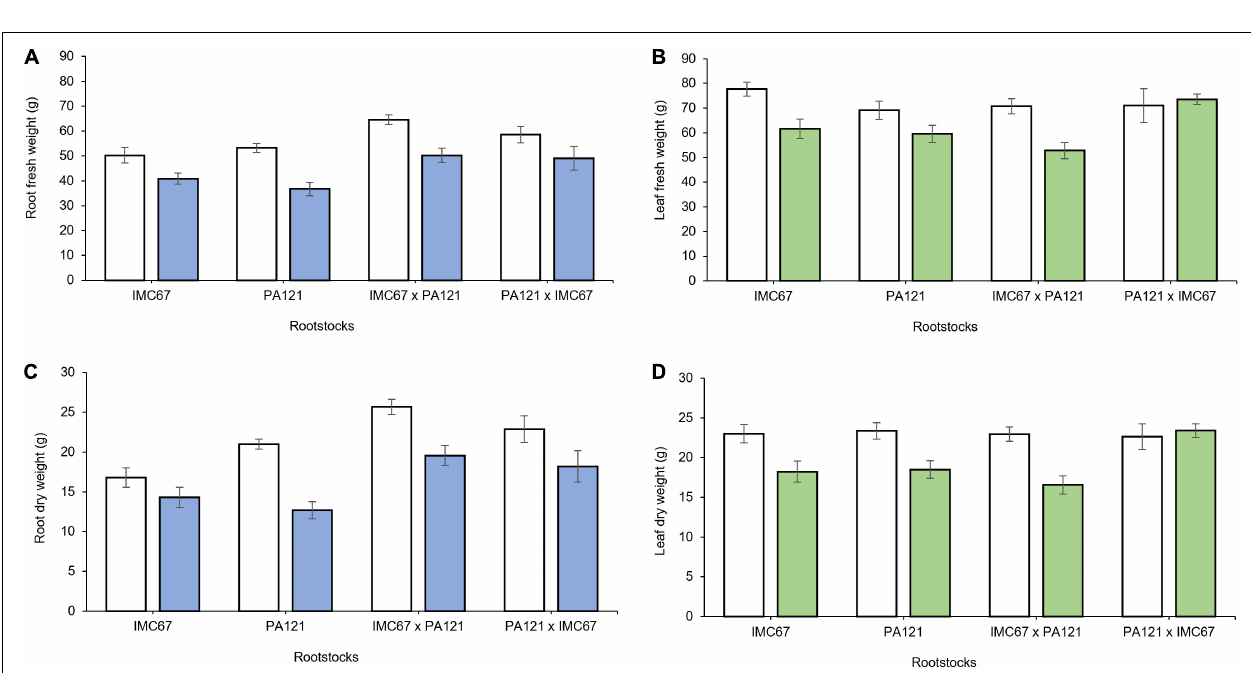
FIGURE 6 | Plant growth of rootstock × scion combinations 4 months after grafting at two different concentrations of Cd in soil under greenhouse conditions. Panels (A,C) show fresh and dry root weight of seedling rootstocks grafted with the ICS95 clonal scion. Panels (B,D) depict fresh and dry leaf weight of the CCN51 clonal scion across rootstock families. White bars represent rootstocks grown in soil without addition of Cd (0.43 mg kg − 1 ). Blue bars represent rootstock families grafted with the ICS95 clonal scion established in Cd spiked soil (7.49 mg kg − 1 ). Green bars represent rootstock families grafted with the CCN51 clonal scion established in Cd spiked soil (7.49 mg kg − 1 ). Data are mean values ± SE ( n = 8).